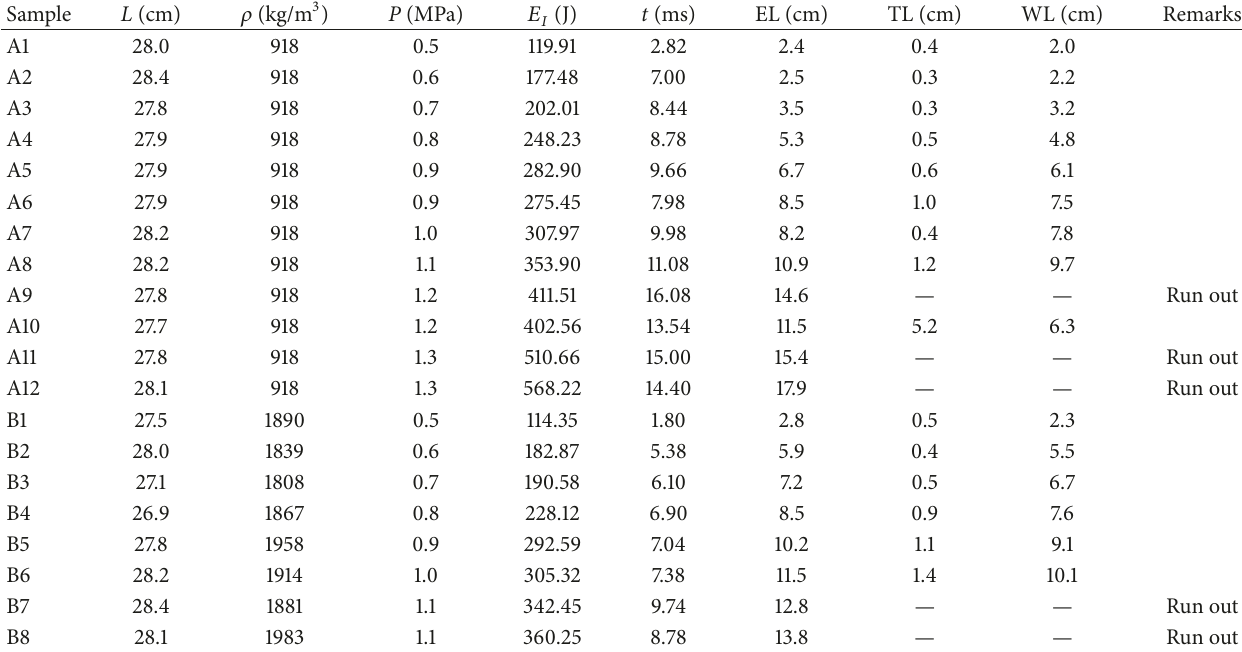
Table 3: Physical and mechanical parameters of different samples under impact load.